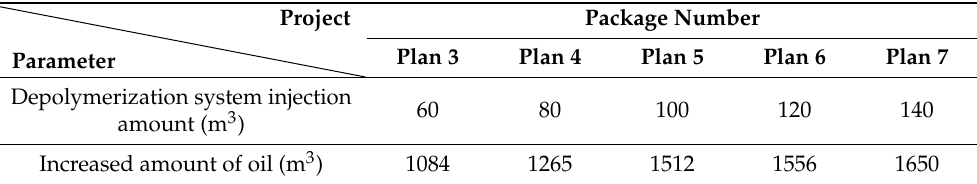
Table 8. Relationship between injection rate and oil increase rate.